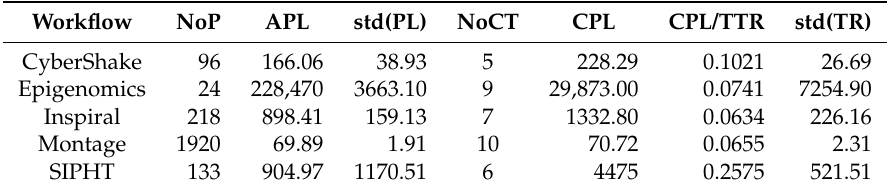
Table 5. Structural parameters of five types of workflows. Number of paths (NoP); average path length (APL); standard deviation of path length (std(PL)); number of critical tasks (NoCT); critical path length (CPL); the ratio of critical path length over total task runtime (CPL/TTR); standard deviation of task runtime